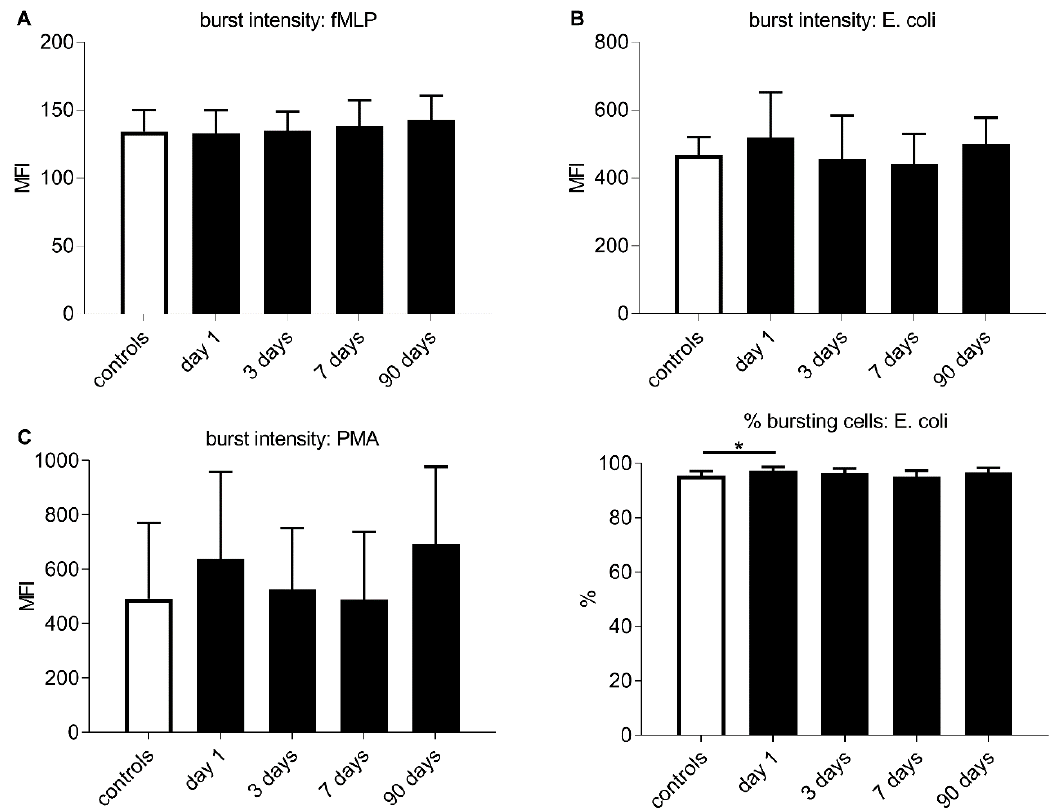
Figure 2. (A–C) Time course of neutrophil oxidative burst intensity represented by the mean fluorescence intensity (MFI) under different stimuli for all stroke patients (black bars) and control levels (white bars). (D) Time course of the percentage of bursting neutrophils after stimulation with Escherichia coli for all stroke patients (black bars) and control levels (white bars). (A–D) Given are group medians and upper interquartile ranges. Testing was performed using Mann–Whitney U